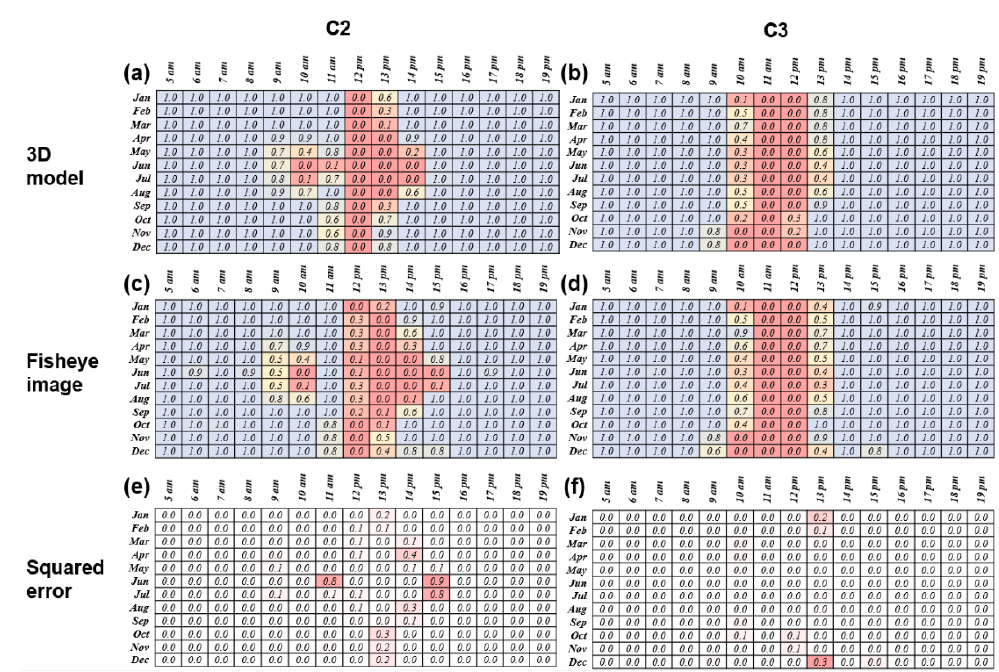
Figure 15. Shading matrices obtained at survey points C2 and C3 using 3D models ( a , b ) and fisheye images ( c , d ), respectively. Squared error matrices between two shading matrices at survey points ( e ) C2 and ( f ) C3.